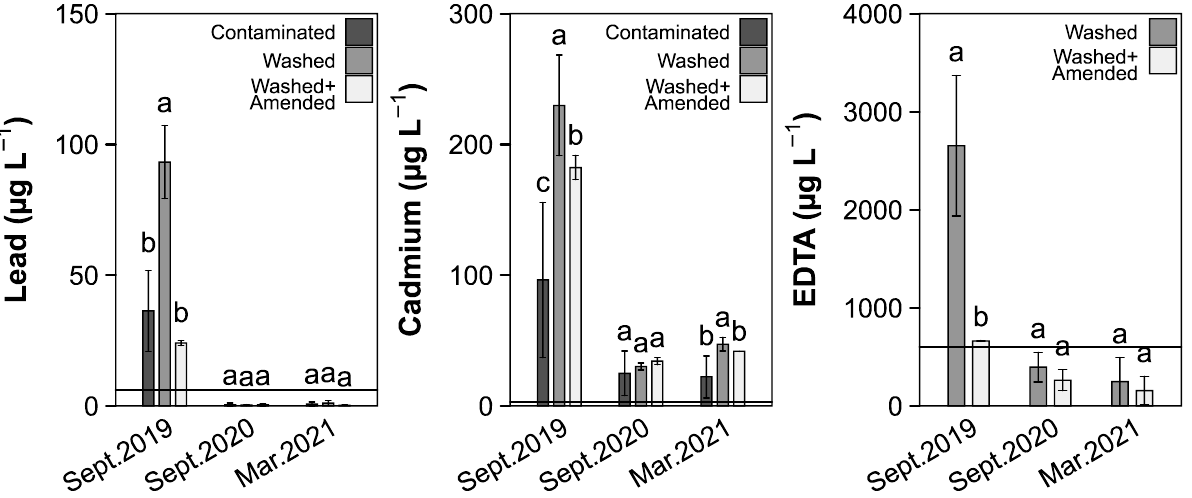
Figure 2. Heavy metal concentration measured in the soil leachate (mean ± SD, n = 4). Different lower-case letters indicate differences between the soil treatments of one sampling point (Dunn test, p < 0.05).